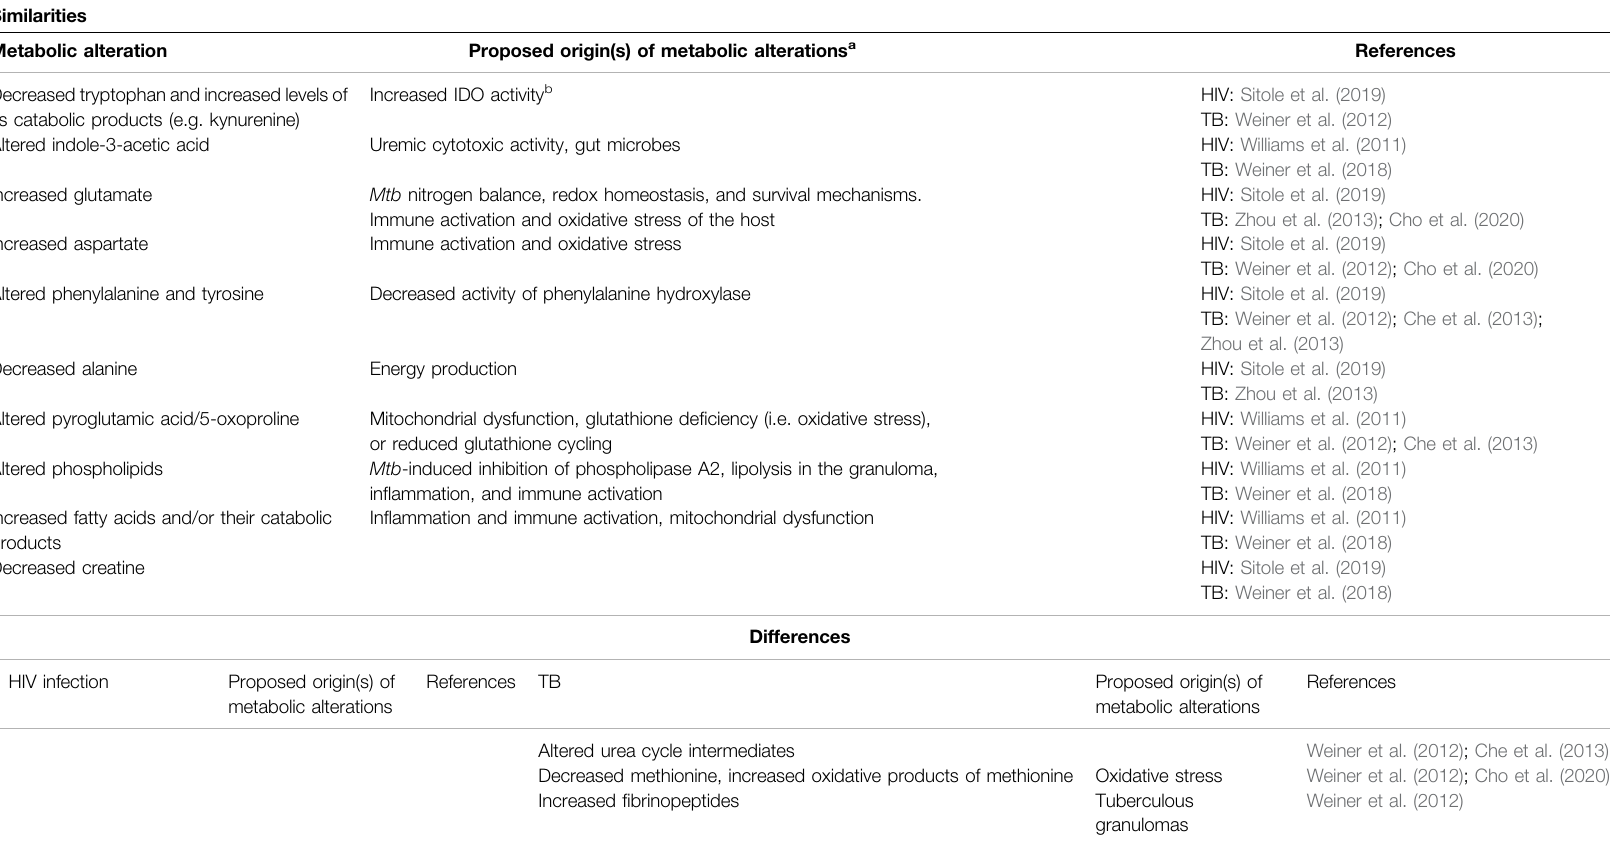
TABLE 2 | A comparison of the fi ndings of HIV infection and TB serum metabolomics